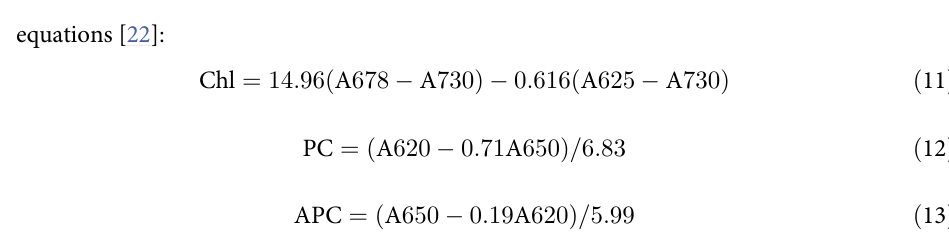
S1 Fig. Absorption spectrum of 147 samples. S2 Fig. Chlorella sp. of N-normal condition. (a)fusion image (b)pure component spectrum. S3 Fig. The images of cyanobacterial algae under different concentration. (a) overlapped and concentrated cells (b) sparse